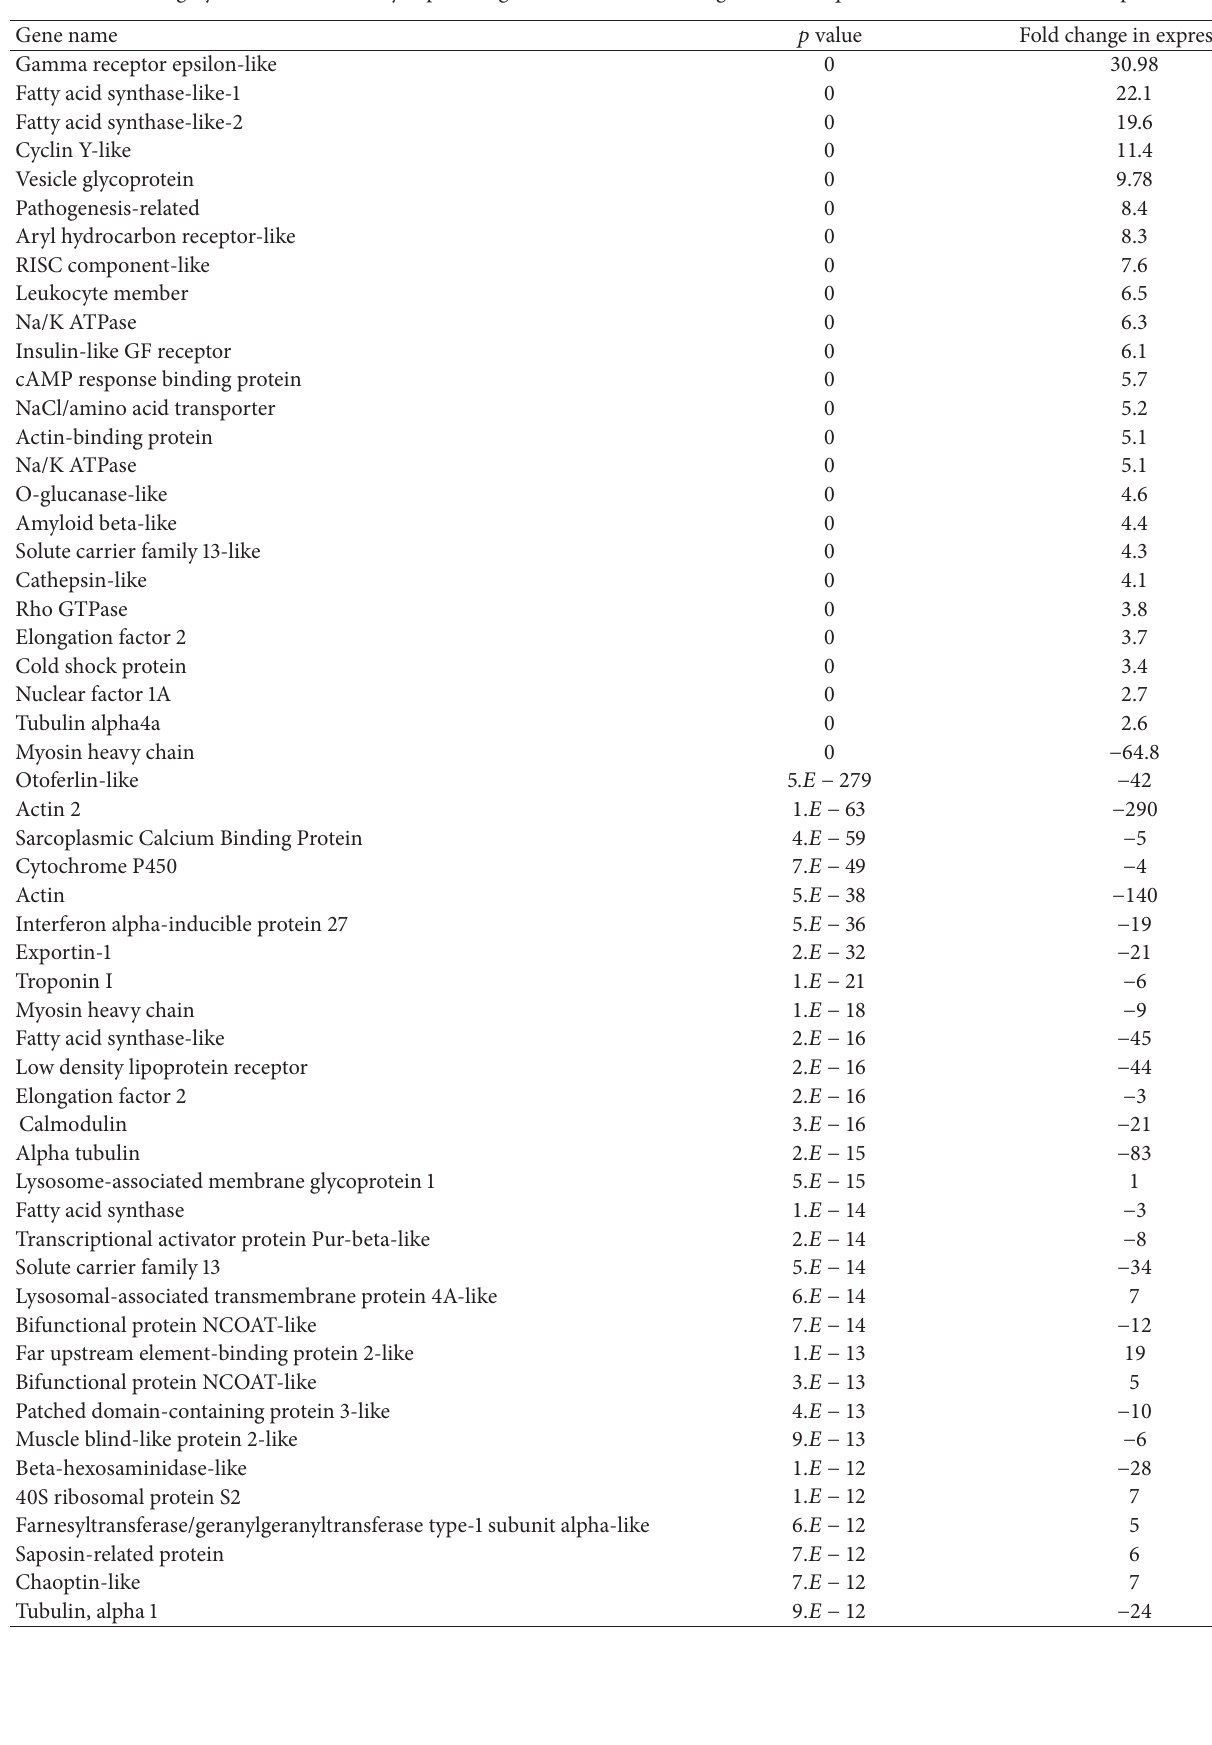
Table 1: Most highly ranked differentially expressed genes in FG clams, listing Bonferroni 𝑝 value and fold-difference compared to